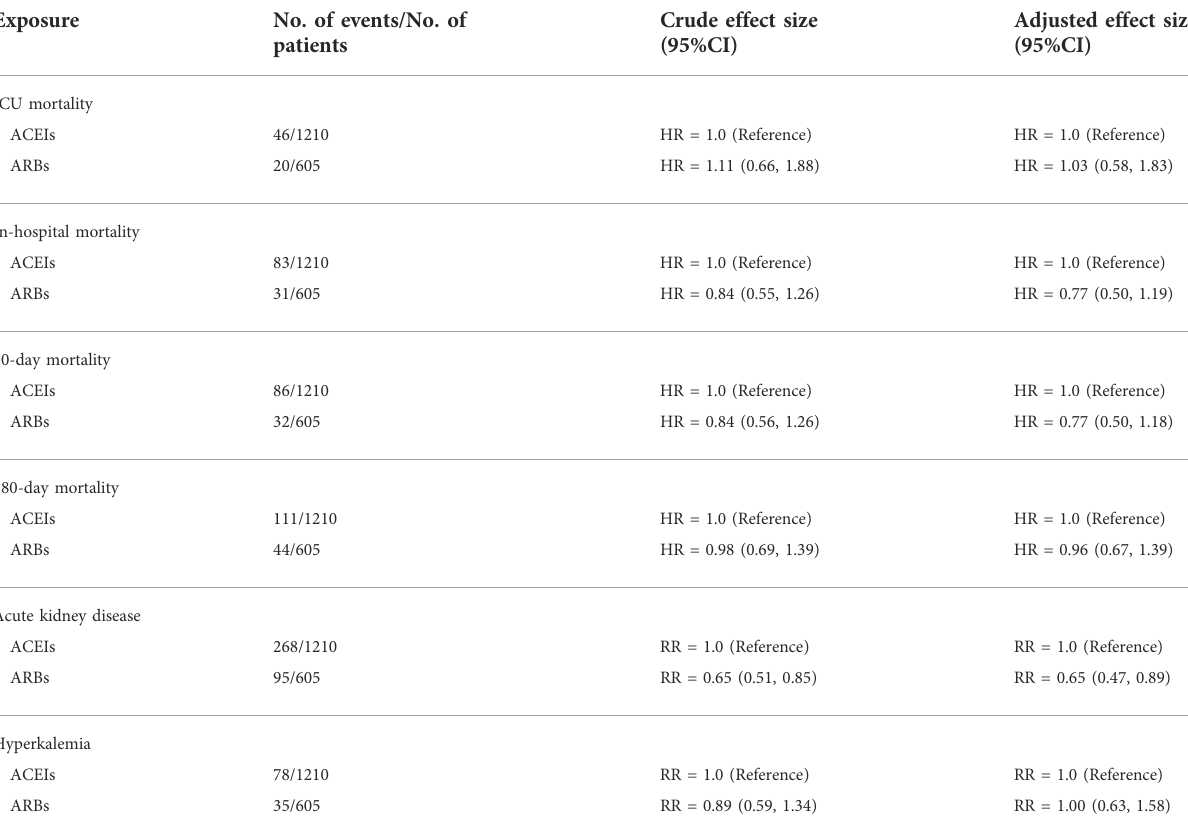
TABLE 3 Outcomes for ARBs compared with ACEIs in propensity score – matched patients with AKI.